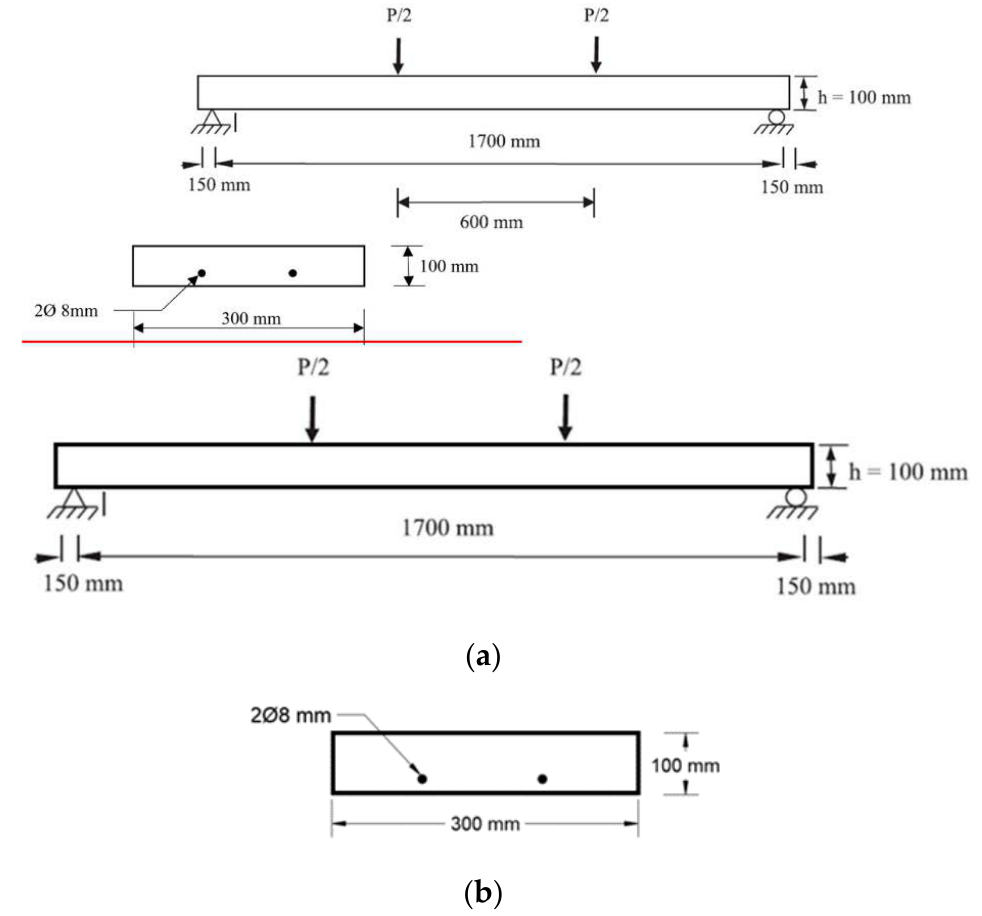
Figure 1. Geometrical configuration and test setup of the tested slab: ( a ) Elevation and location of loading; ( b ) Cross section of the slab.